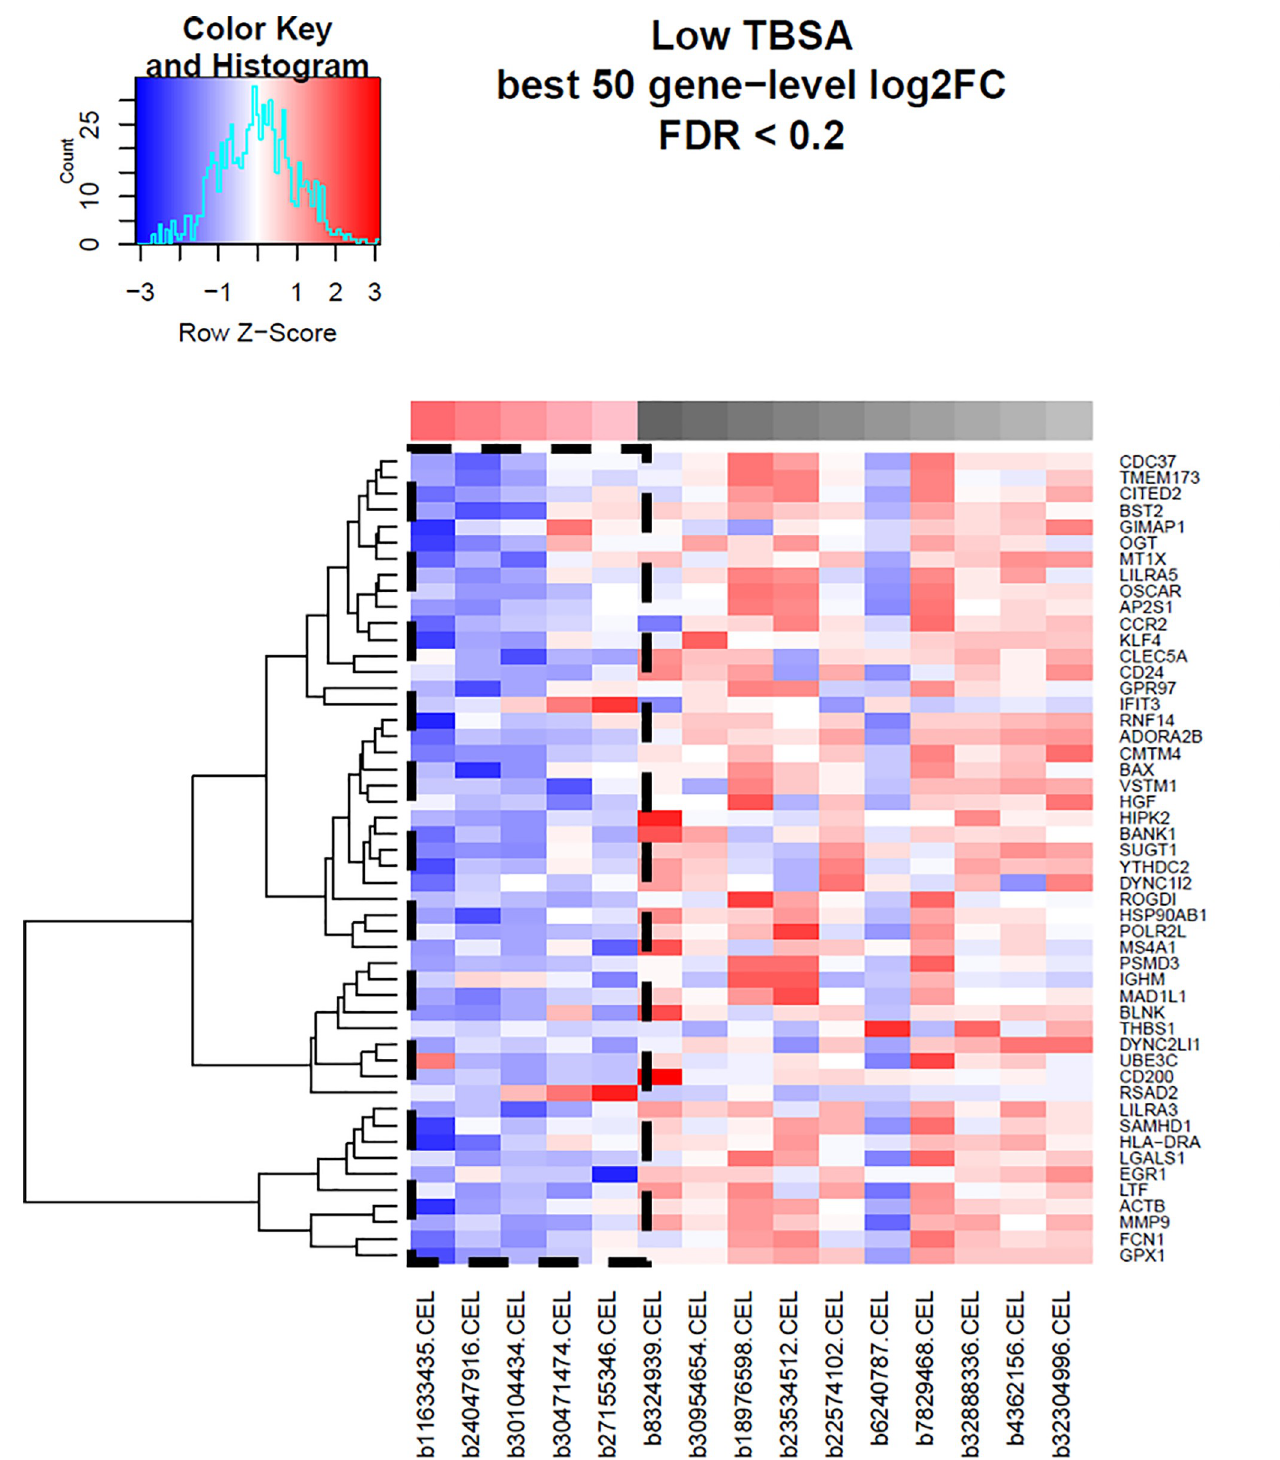
Fig 6. Heat map for comparison group 3 (low TBSA). Generated from hierarchical clustering of differentially expressed immune-related genes. The top colour blocks identify the sample type; red = elderly, black = adult, and shading corresponds to TBSA values. The color key outlines the degree of expression for each listed. gene. Boxed areas highlight downregulated genes in the elderly